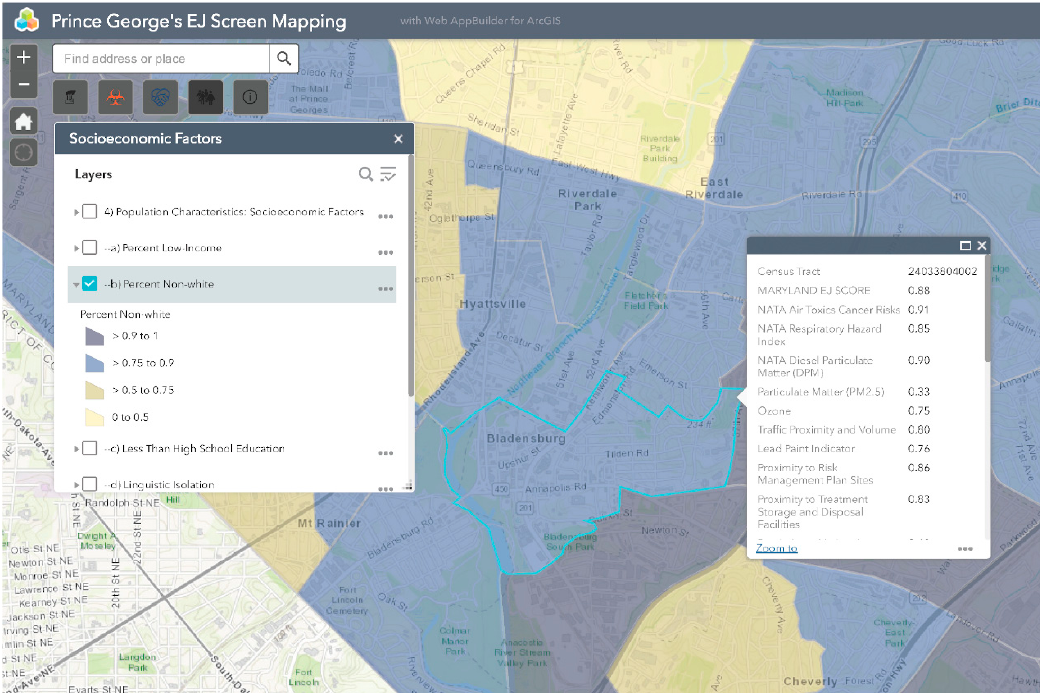
Figure 3. PG EJ score for Bladensburg. This screenshot from the MD EJSCREEN mapping tool shows the PG EJ score of Bladensburg, MD.